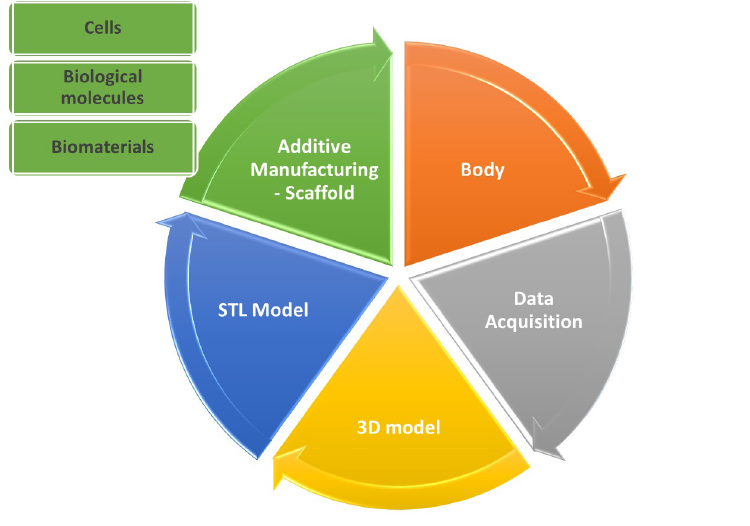
Figure 3. Schematic representation of the main steps required to produce TE scaffolds using AM